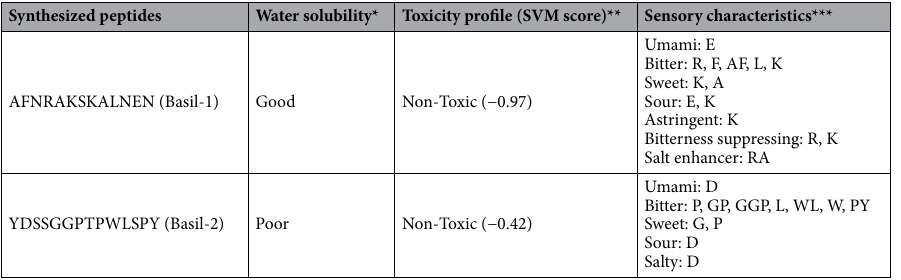
Table 1. Properties of Basil-1 and Basil-2. *Innovagen server is the source of data on peptide solubility (www. innov agen. com/ prote omics- tools). **Peptide toxicity analysis is carried out via the ToxinPred server (http:// crdd. osdd. net/ ragha va/ toxin pred/). ***BIOPEP-UWM website (http:// www. uwm. edu. pl/ bioch emia/ index. php/ pl/ biopep) facilitates the sensory characterization of